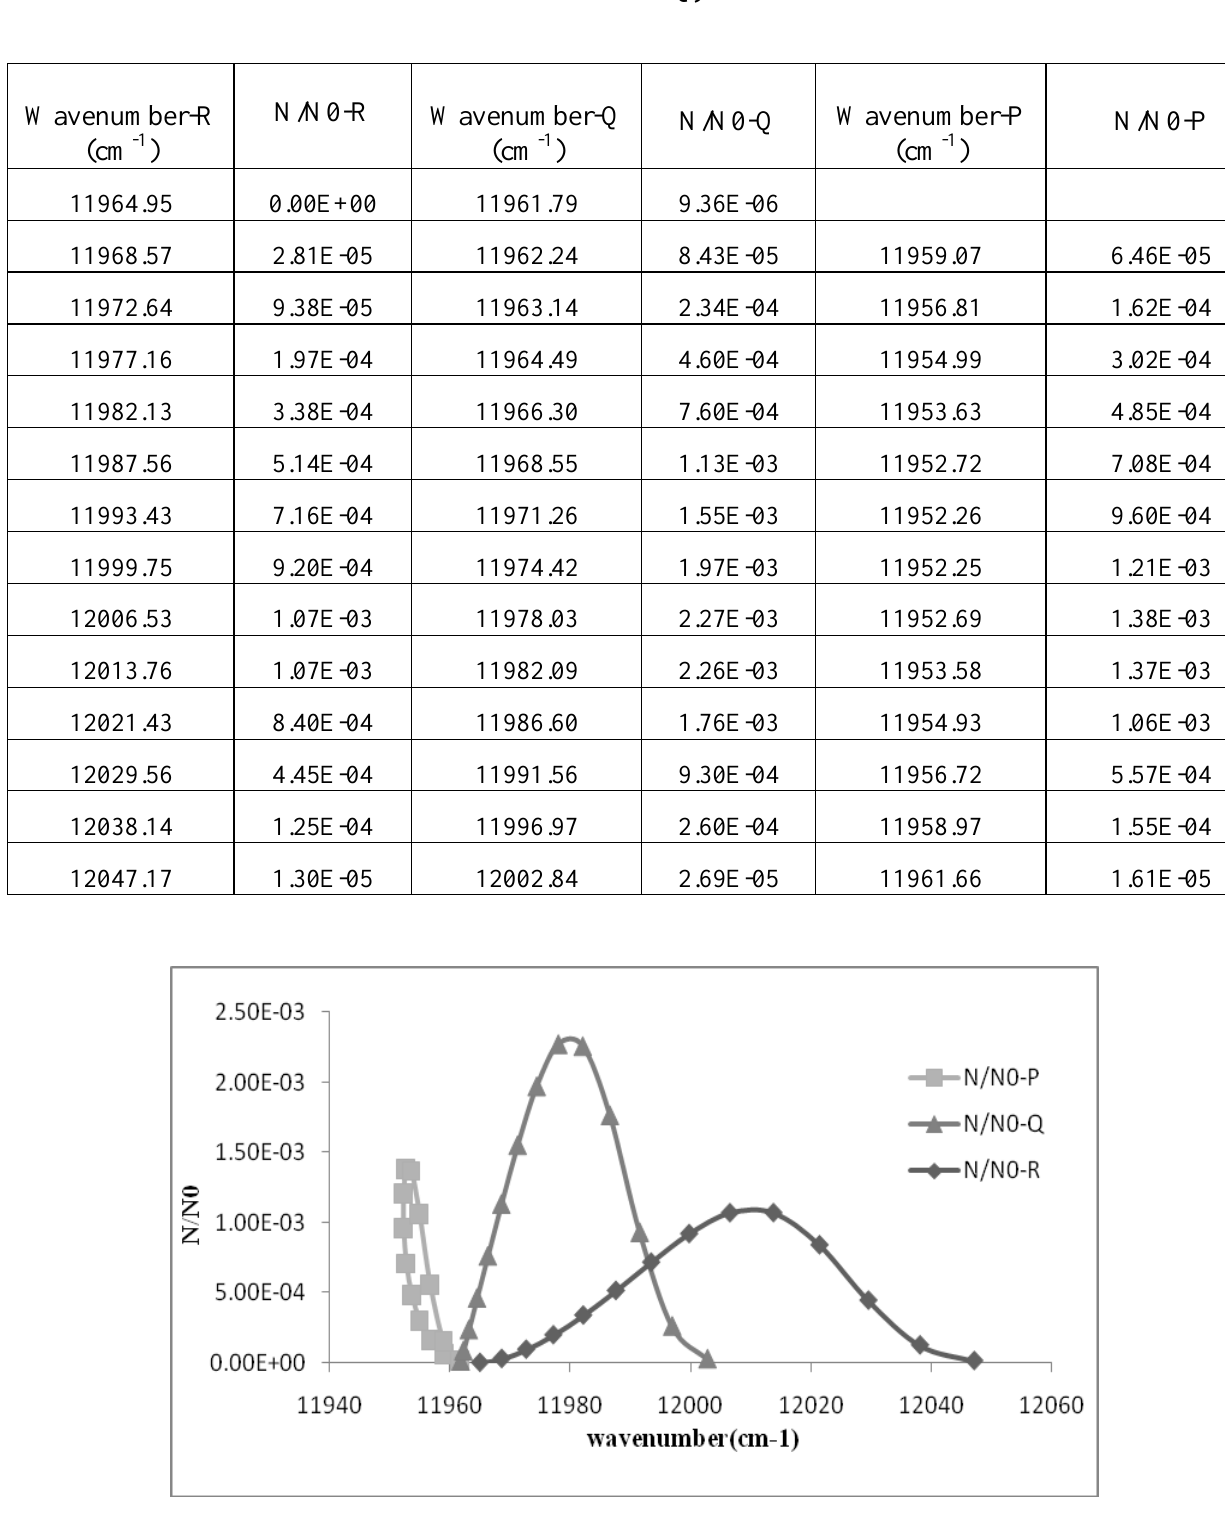
Fig.4: Relative population of B 1 Σ + - A 1 Π as a function of wavenumber for BeO molecule.